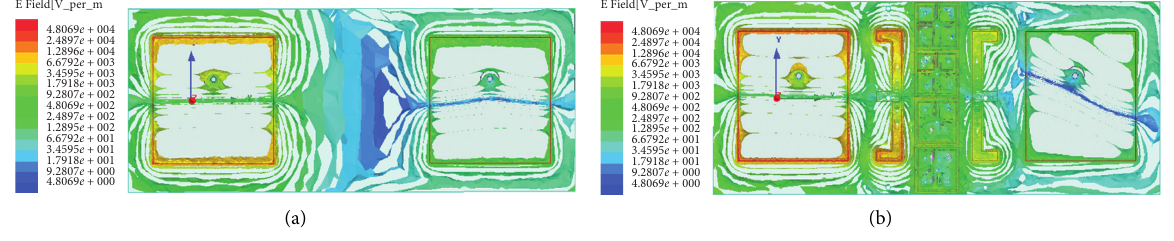
Figure 8: Electric field distribution: (a) AT1; (b)